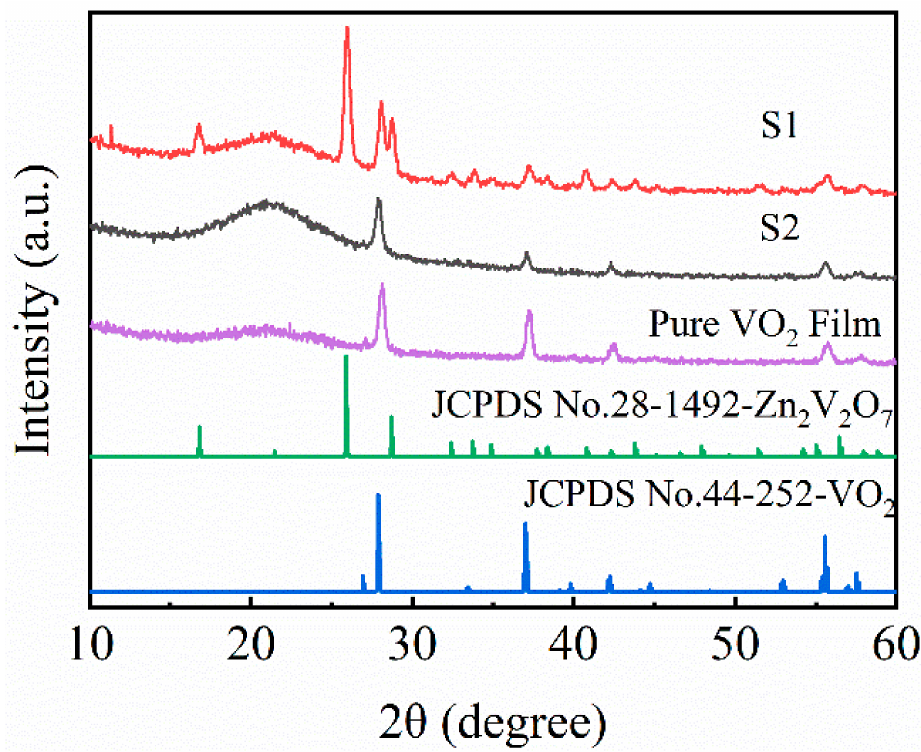
Figure 2. XRD patterns of sample S1, S2 and pure VO 2